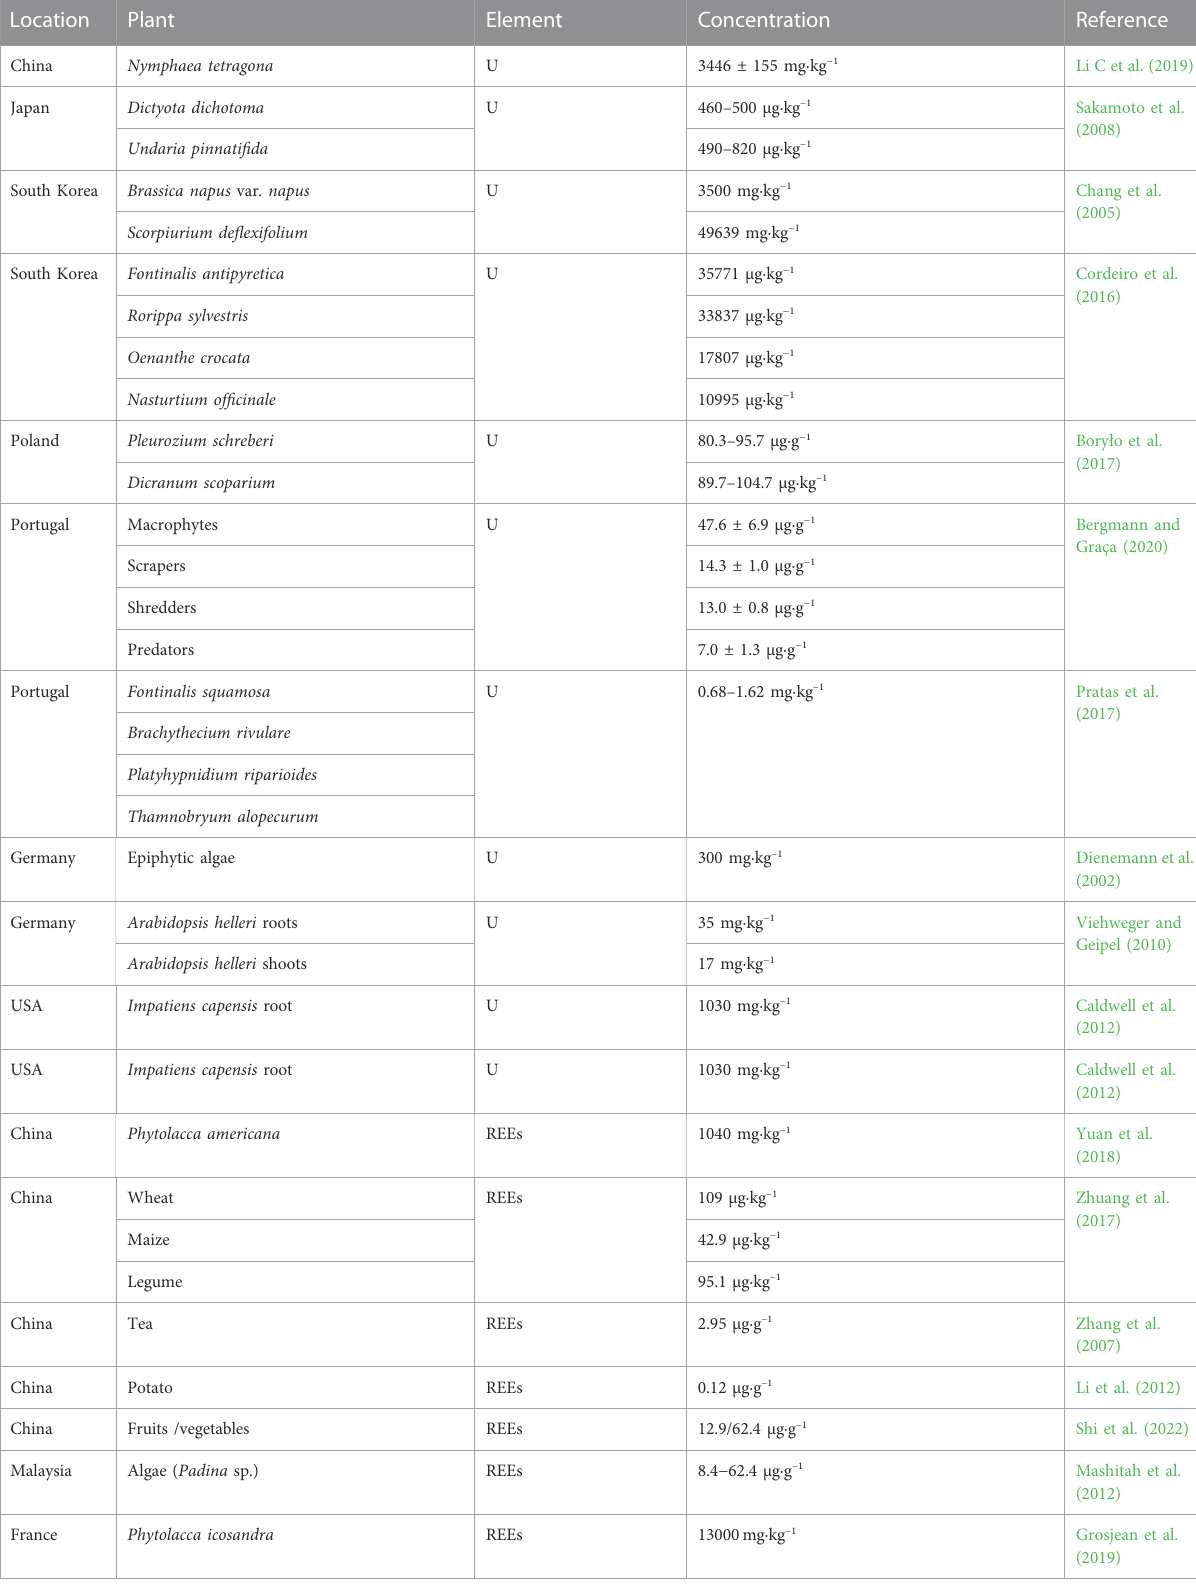
TABLE 6 Contents of U and REEs in